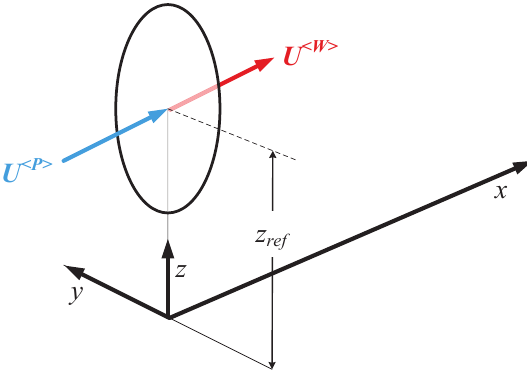
Figure 17. Coordinate system definition for reference.